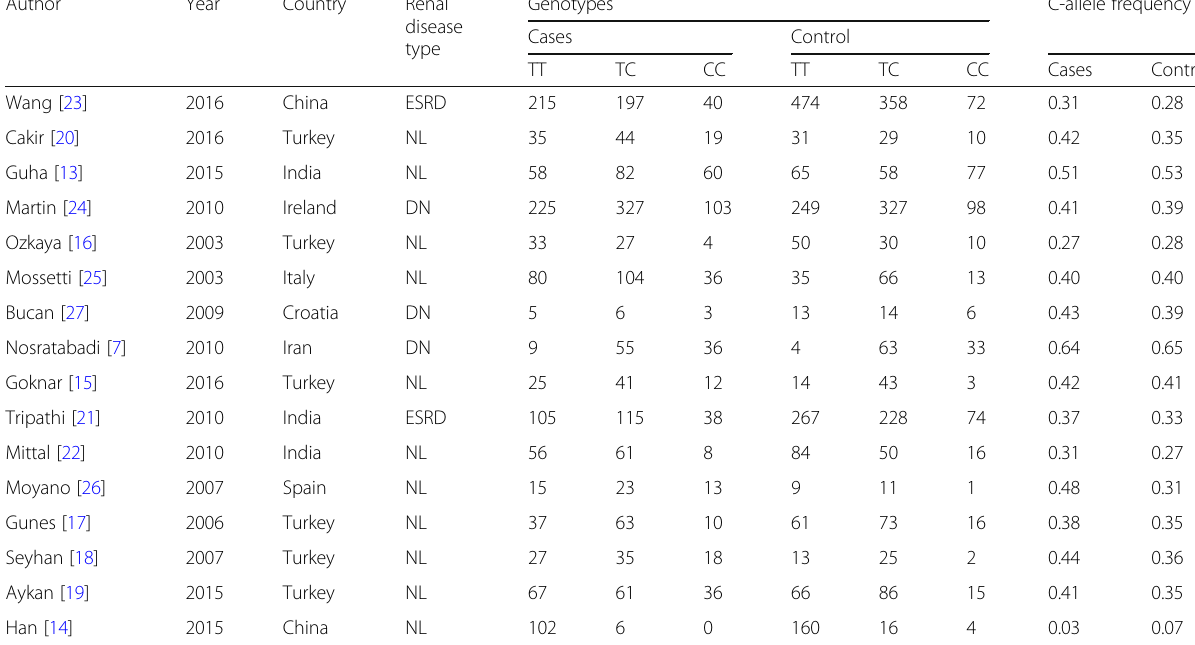
Table 1 Distribution of VDR1 TaqI polymorphism in different case-control studies